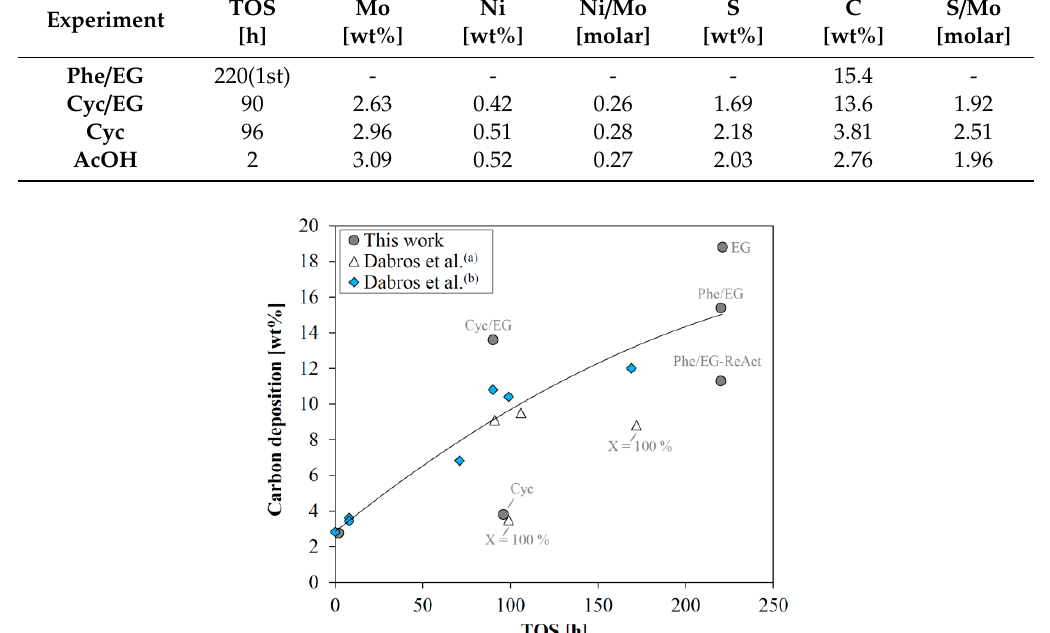
Table 5. Composition of spent catalysts.